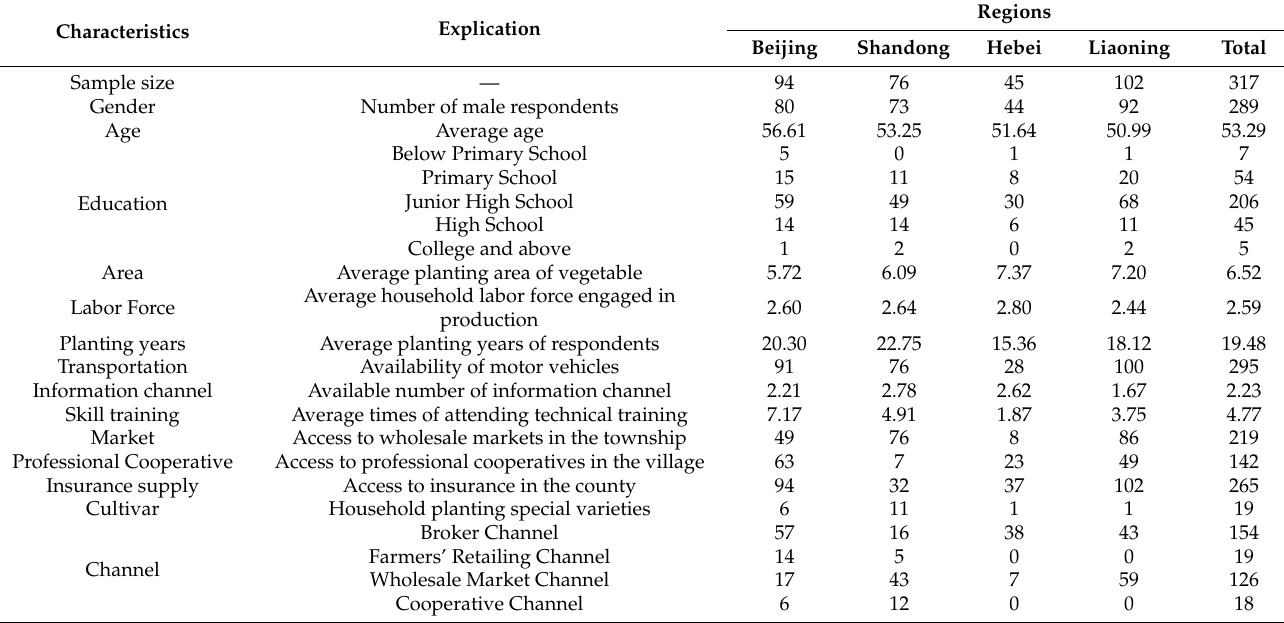
Table 2. A description of the survey